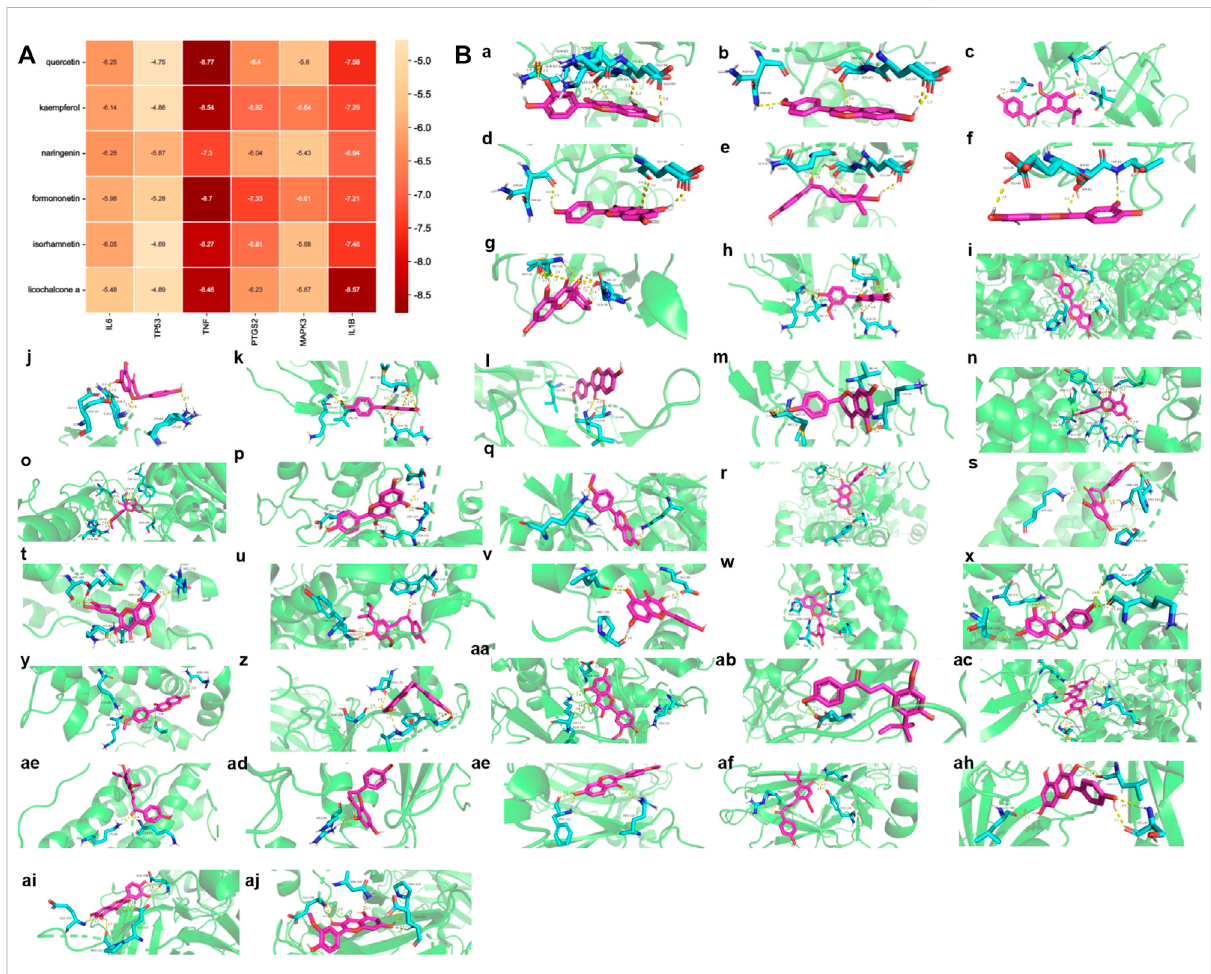
FIGURE 7 Ingredients-TargetsMolecularDocking (A) .ThebindingenergyofthemainactivecomponentsofSGFDandthekeytargets. (B) .Thebindingsite of the main active components of SGFD and the key targets. The molecular docking poses of Quercetin — TNF (a) , Formononetin — TNF (b) , Licochalcone A — IL1 β (c) , Kaempferol — TNF (d) , Licochalcone A — TNF (e) , Isorhamnetin — TNF (f) , Quercetin — IL1 β (g) , Isorhamnetin — IL1 β (h) , Formononetin — PTGS2 (i) , Naringenin — TNF (j) , Kaempferol — IL1 β (k) , Formononetin — IL1 β (l) , Naringenin — IL1 β (m) , Kaempferol — PTGS2 (n) , Isorhamnetin — PTGS2 (o) , Kaempferol — MAPK3 (p) , Formononetin — MAPK3 (q) , Quercetin — PTGS2 (r) , Naringenin — IL6 (s) , Quercetin — IL6 (t)